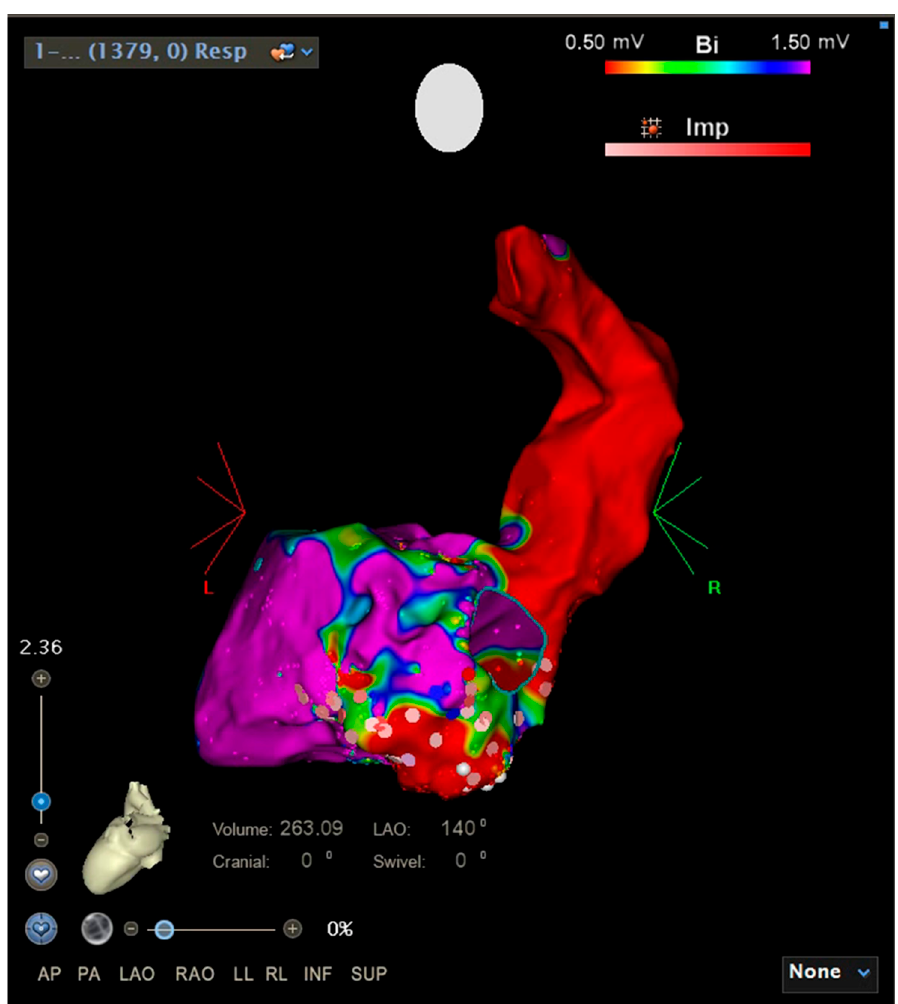
Figure 2. Electroanatomic map of the left ventricle at the end of ablation: low voltage areas (red in color) correspond to the infarct scar, pink points are the ablation points.